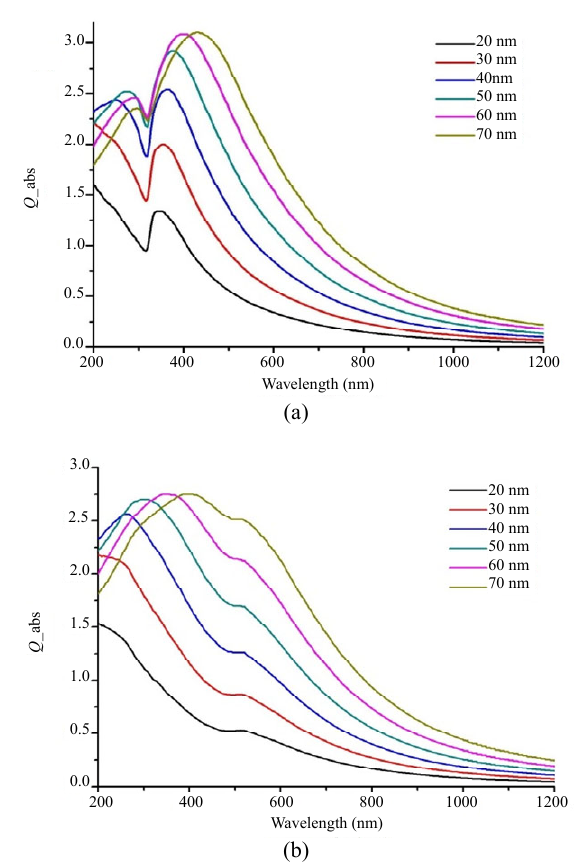
Fig. 2 Absorption efficiency for (a) Ag 1- x -Fe x and (b) Au 1- x -Fe x (composition, x =0.50) alloy nanoparticles with different